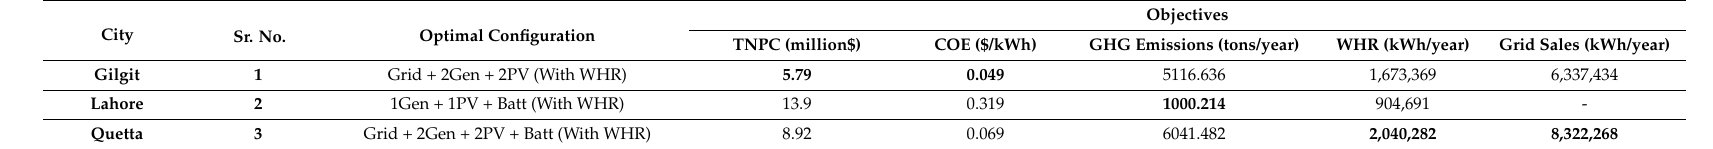
Table 8. Most optimal values of each objective in different optimal